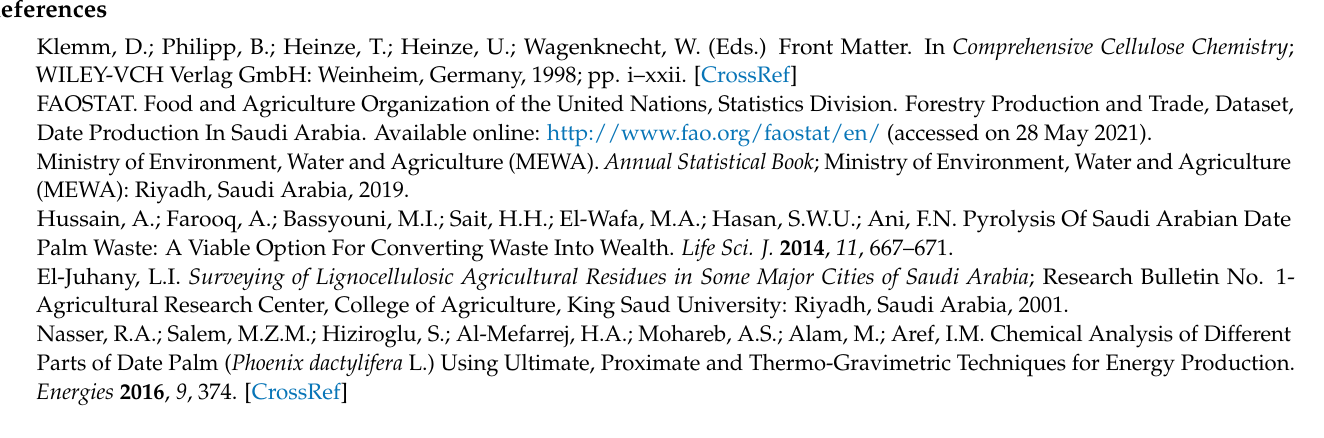
of delignified mesh, Figure S3: EXD analysis of cellulose, Figure S4: EXD analysis of